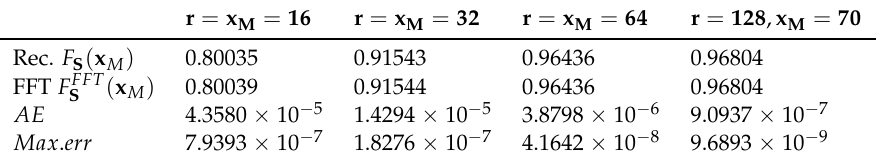
Table 3. Example 2: Comparing recursive and FFT methods for h = 1, θ = 7/ r and various r , x M . r = x M =